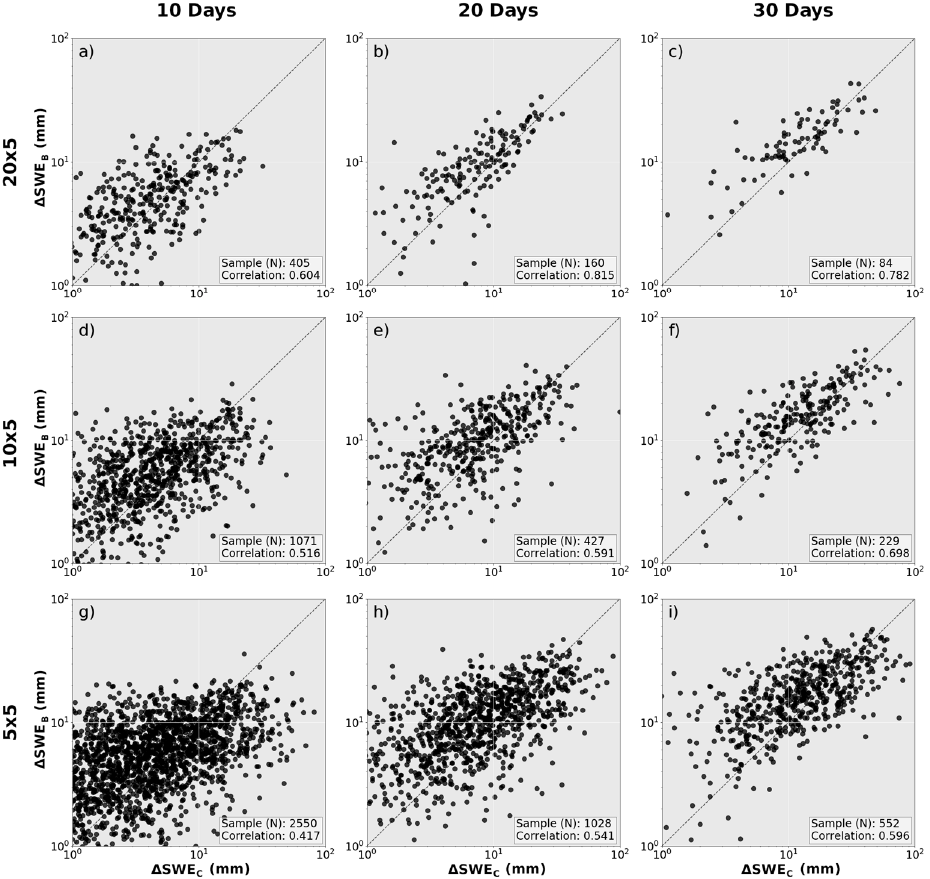
Figure 5. Comparisons between B4 and CloudSat estimates of ∆ SWE at different spatiotemporal resolutions. Subplots ( a , d , g ) have 10 day time periods. Subplots ( b , e , h ) have 20 day time periods. Subplots ( c , f , i ) have 30 day time periods, Subplots ( a – c ) have 20 ◦ × 5 ◦ spatial resolution.